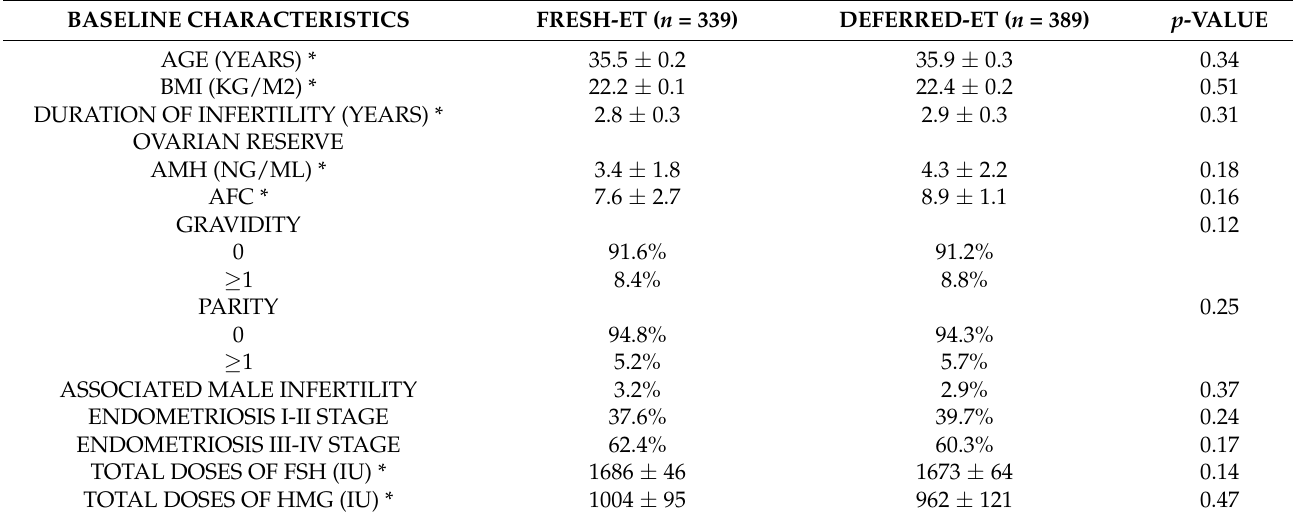
Table 1. Baseline patient characteristics.